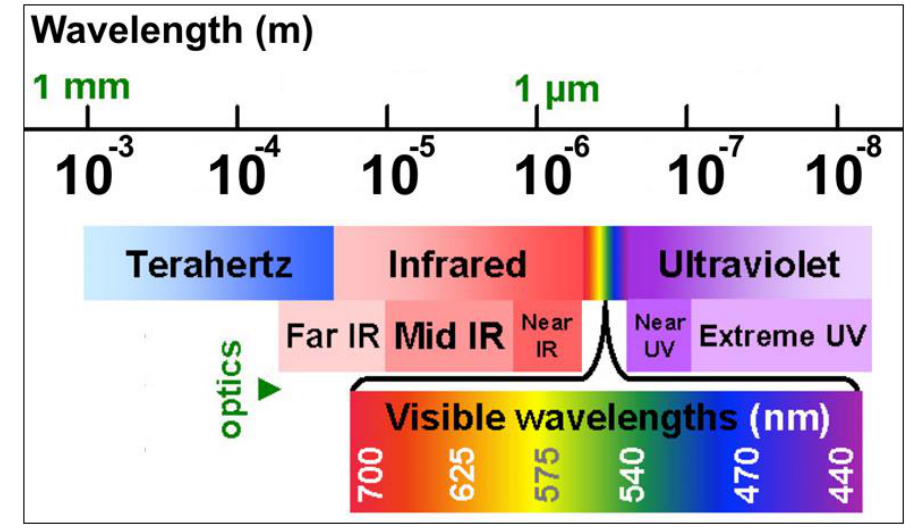
Figure 1. The electromagnetic spectrum.